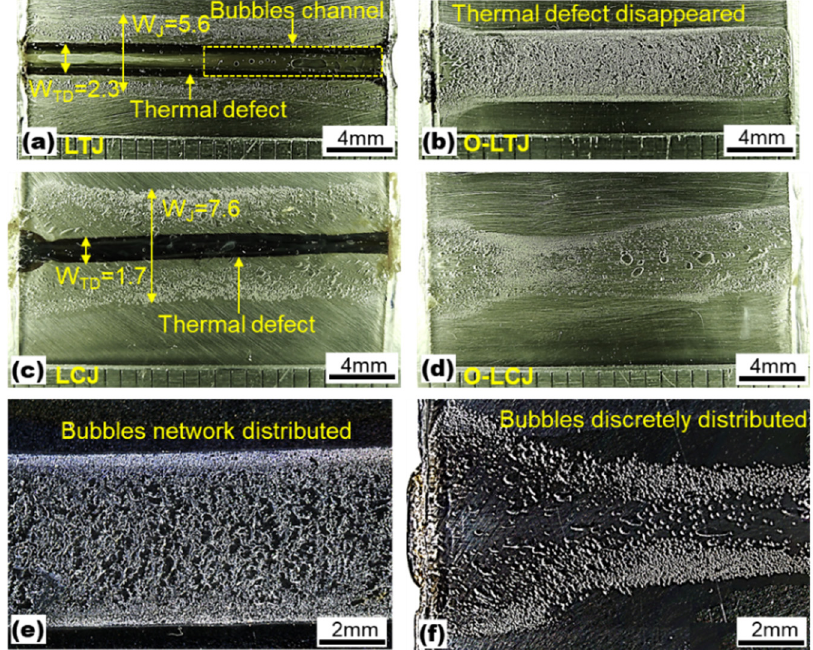
Figure 2. Joint macroscopic morphologies: ( a ) laser transmission joining (LTJ), ( b ) oscillating laser transmission joining (O-LTJ), ( c ) laser conduction joining (LCJ), ( d ) oscillating laser conduction joining (O-LCJ), ( e ) magnification of O-LTJ, ( f ) magnification of O-LCJ.